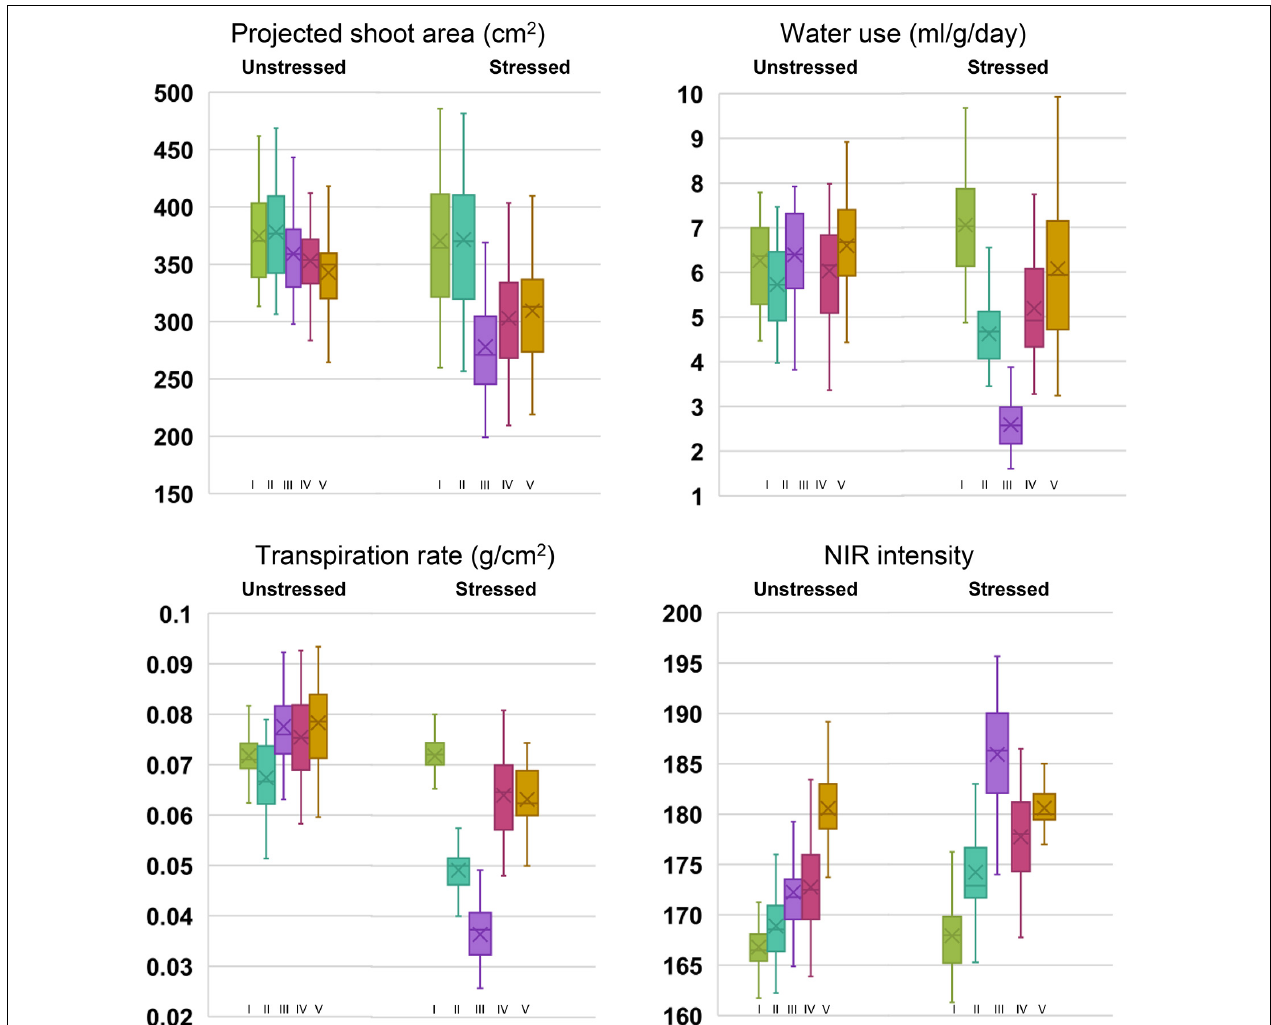
FIGURE 2 | Box plots of phenomics parameters, projected shoot area (PSA), water use (WU), transpiration rate (TR), and near-infrared values (NIR) among the genotypes under stressed and unstressed treatments for five stages of drought exposure. Stages I to V corresponds to the initial phase without drought (0 days), 5 days after withholding irrigation in drought set, peak drought phase at 10 days after drought imposition when soil moisture content reached 12%, two days after irrigation, and 5 days into the recovery phase,